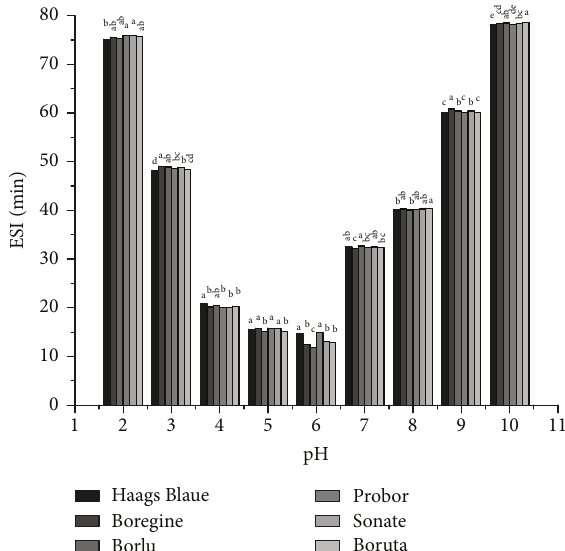
Figure 3: Effect of pH on the emulsion stability index (ESI) of six varieties of Lupinus angustifolius protein isolates. Different letters indicate significant differences among varieties at 𝑃 < 0.05